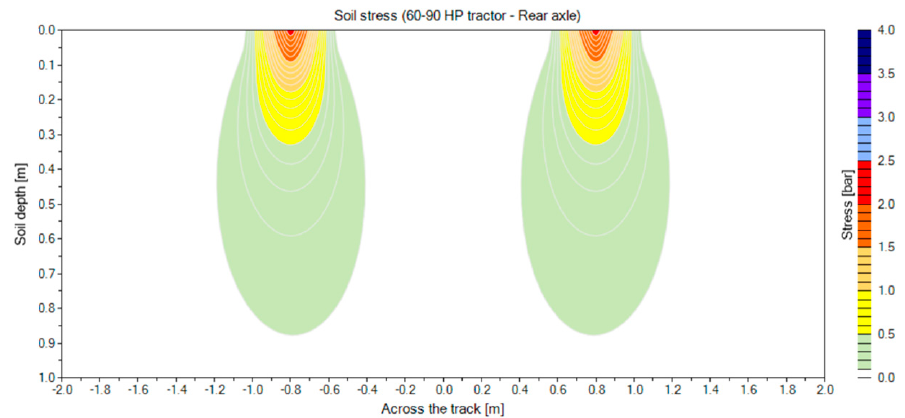
Figure 4. Soil stress simulation results of the rear tyre using Terranimo.